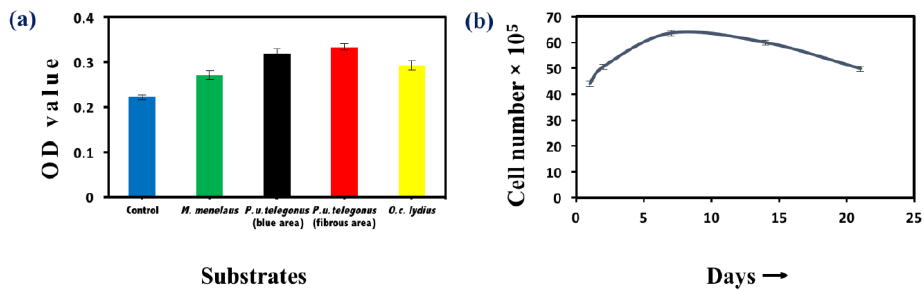
Figure 5. Cell viability assay. ( a ) Methylthiazolyldiphenyl-tetrazolium bromide (MTT) assay of HepG2 cells cultured on different substrates: M. menelaus , P. u. telegonus (blue area), P. u. telegonus (fibrous area), O. c. lydius wings, and cell culture dish (control) after 48 h. ( b ) Long period culture of HepG2